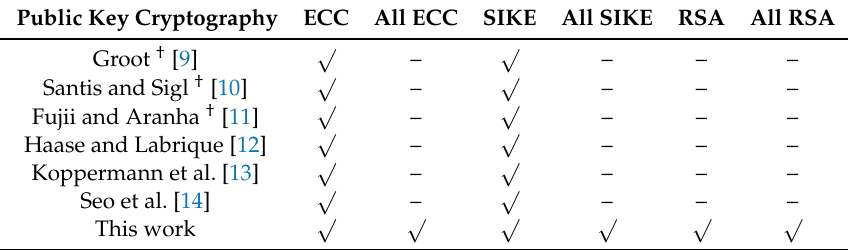
Table 4. Comparison of practical